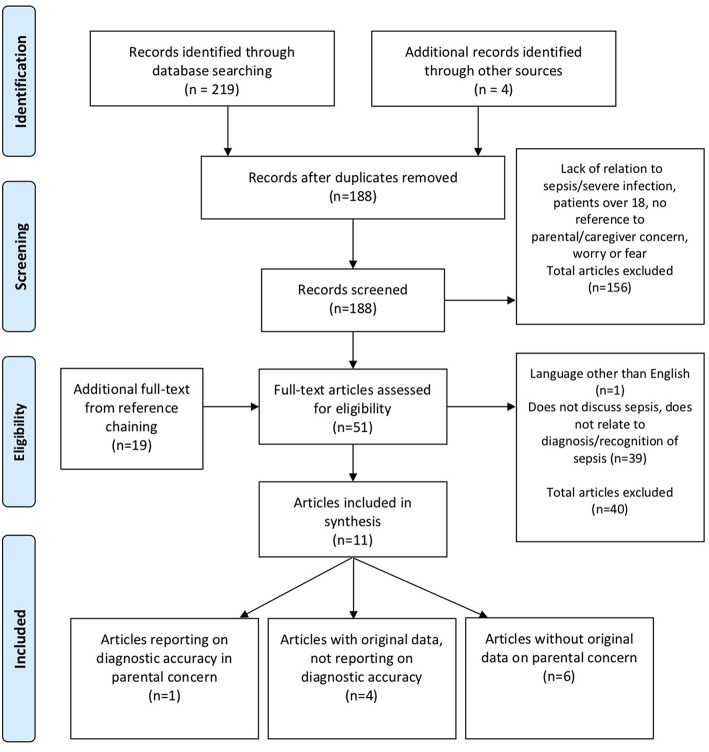
PRISMA flow diagram.